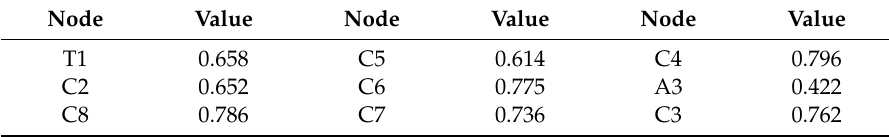
Table 8. Membership function value of the underlying factor.